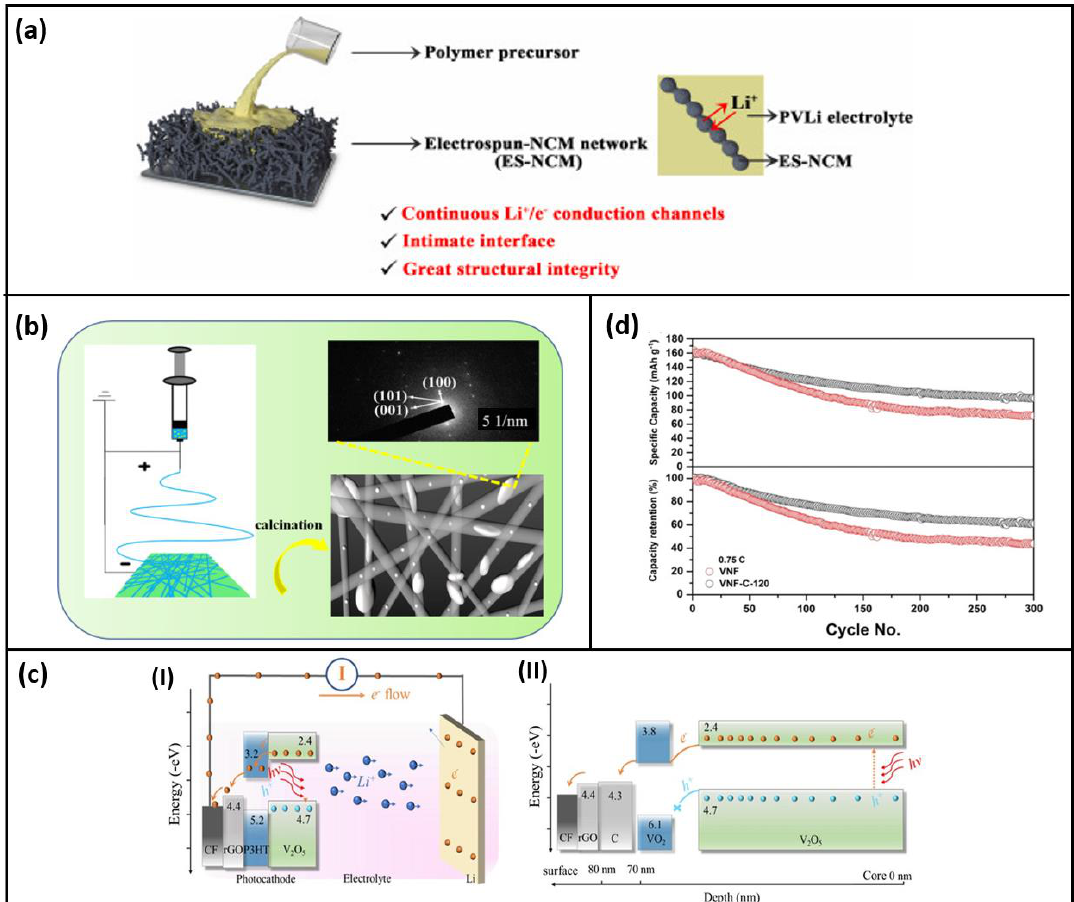
Figure 4. ( a ) Schematic illustration for the construction of composite ES–NCM cathode based on proposed interface engineering strategy (reused with copyrights from Ref. [53] 2022, Elsevier) ( b ) Schematic illustration of the free-standing (010)-oriented LiFePO4/carbon fibers (reused with copyrights from Ref. [23] 2020, Elsevier) ( c ) Schematic representing the photo charging mechanism of (I) VNF and (II) VNF-C-120 (reused with copyrights from Ref. [54] 2022, Wiley) ( d ) Cycling stability and capacity retention tests at 0.75 C of VNF (red) and VNF-C-120 (gray) (reused with copyrights from Ref. [54] 2022,